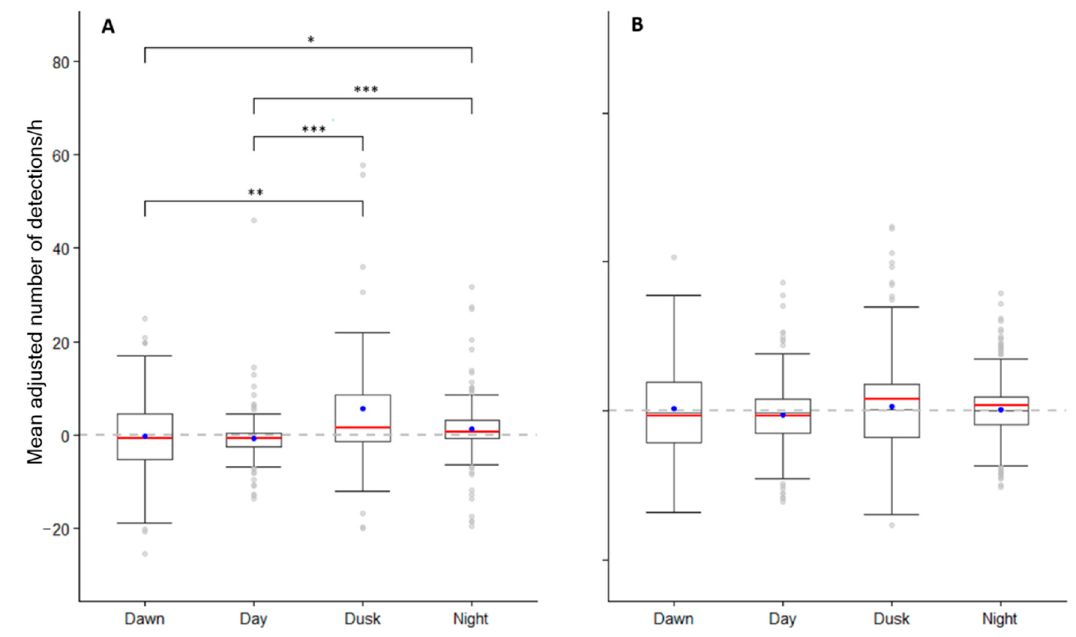
Figure 7. Boxplot of mean-adjusted number of D ( A ) and SEP ( B ) call detections per hour during four light regimes. Lower and upper bounds of whiskers represent lower and upper quartiles respectively. Red lines are median values, blue dots are mean values, and grey dots represent outliers. Asterisks denote statistically significant differences: * = p < 0.05; ** = p < 0.01; *** = p < 0.001. Note that means can differ from medians due to outliers.